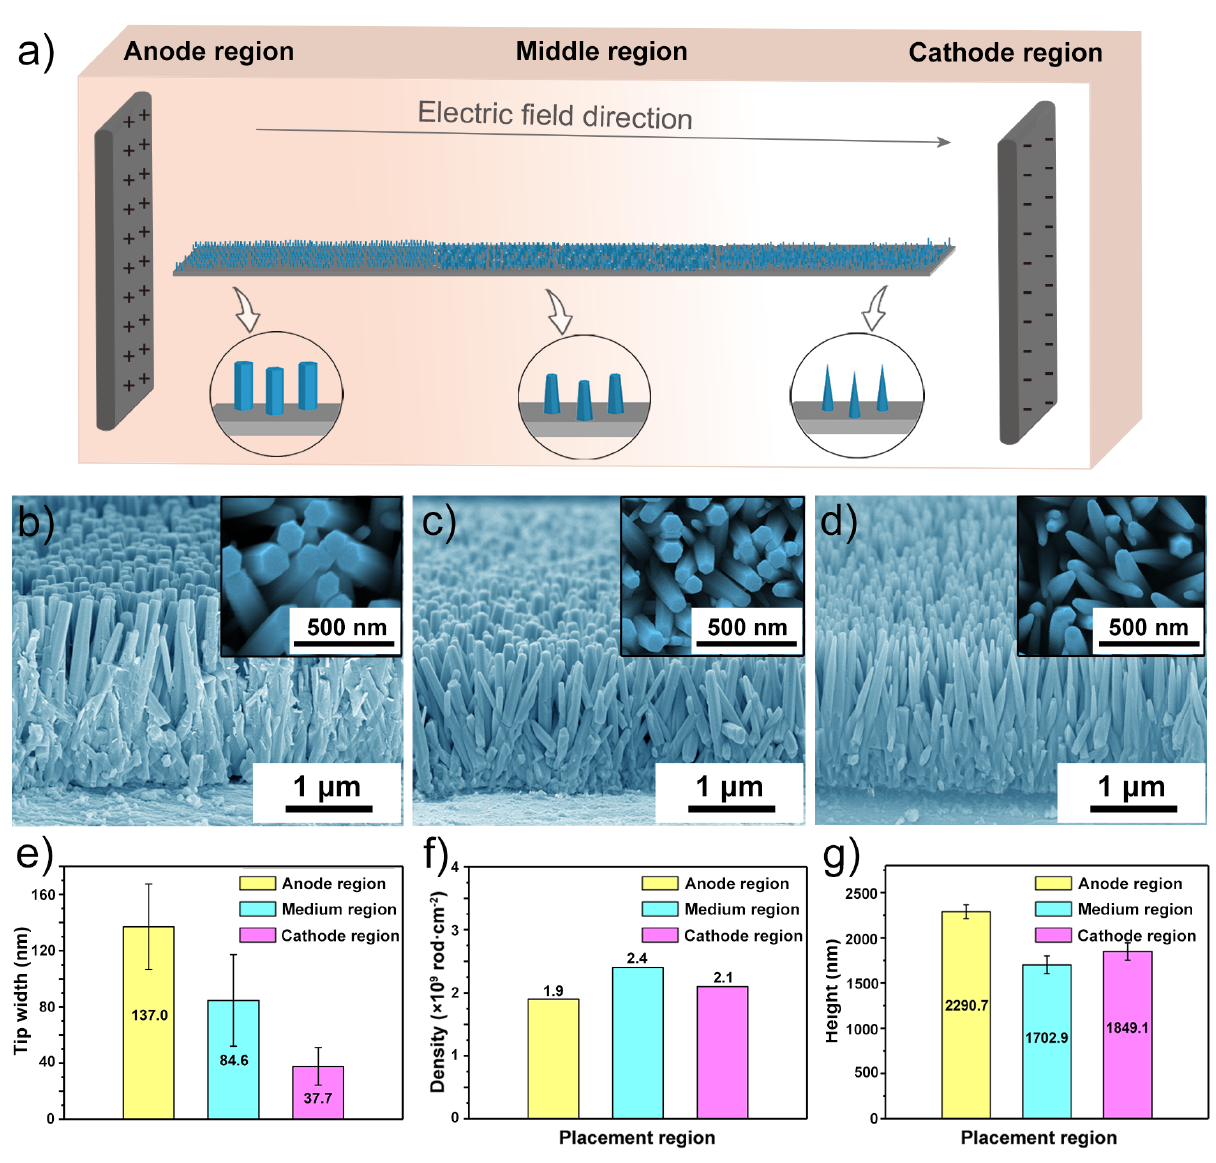
Figure 1: The experimental setup a) and changes in ZnO NAs topography under the influence of setting position of samples. The gradient red shows the gradient change of Zn(OH)2- 4 concentration. SEM images of b) anode region; c) middle region and d) cathode region; topographic parameters: e) tip-width, f) density and g) height, as determined by SEM.